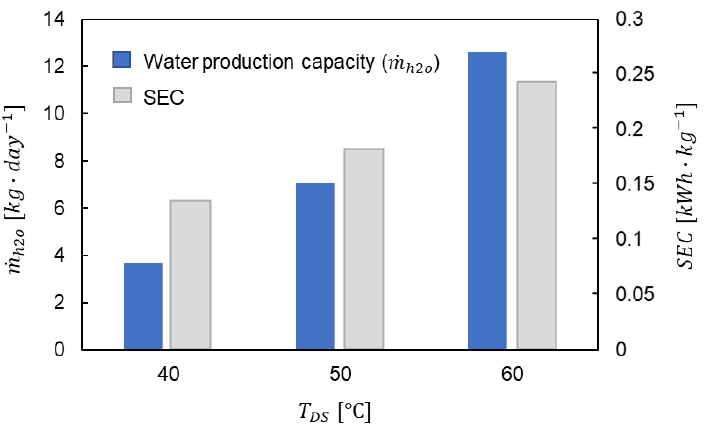
Figure 11. Water production capacities and SECs of a single WavoWater system according to the DS temperature ( 𝑇 𝐷𝑆 ).